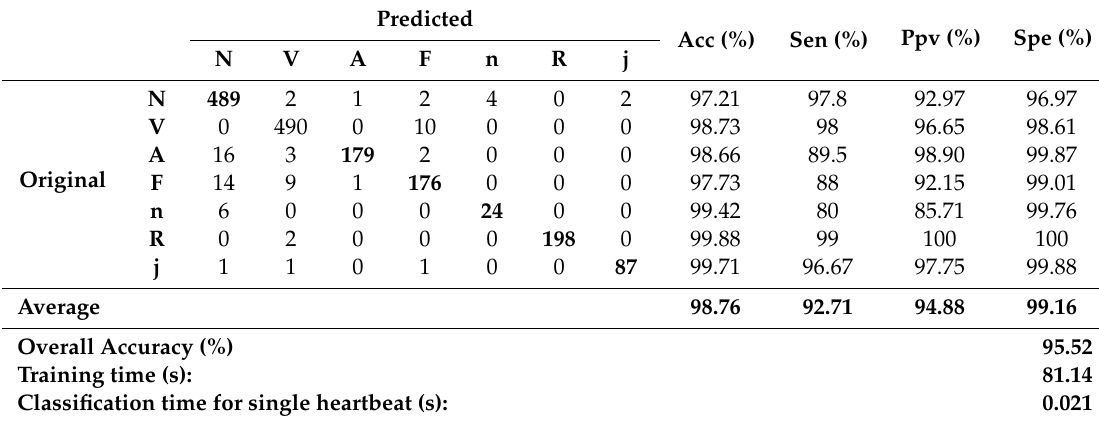
Table 14. Confusion matrix obtained using II, V1, and V5 leads across 5